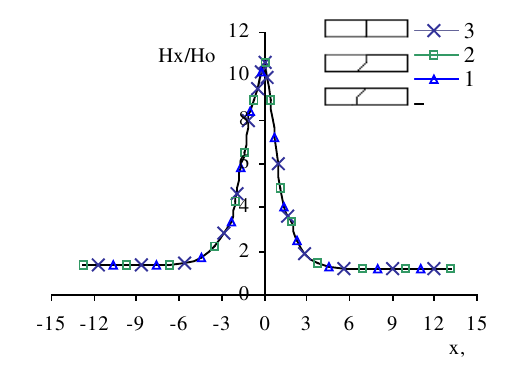
Fig 15. Dependence H x ( x ) for three types of defects ( h = 4 nm;